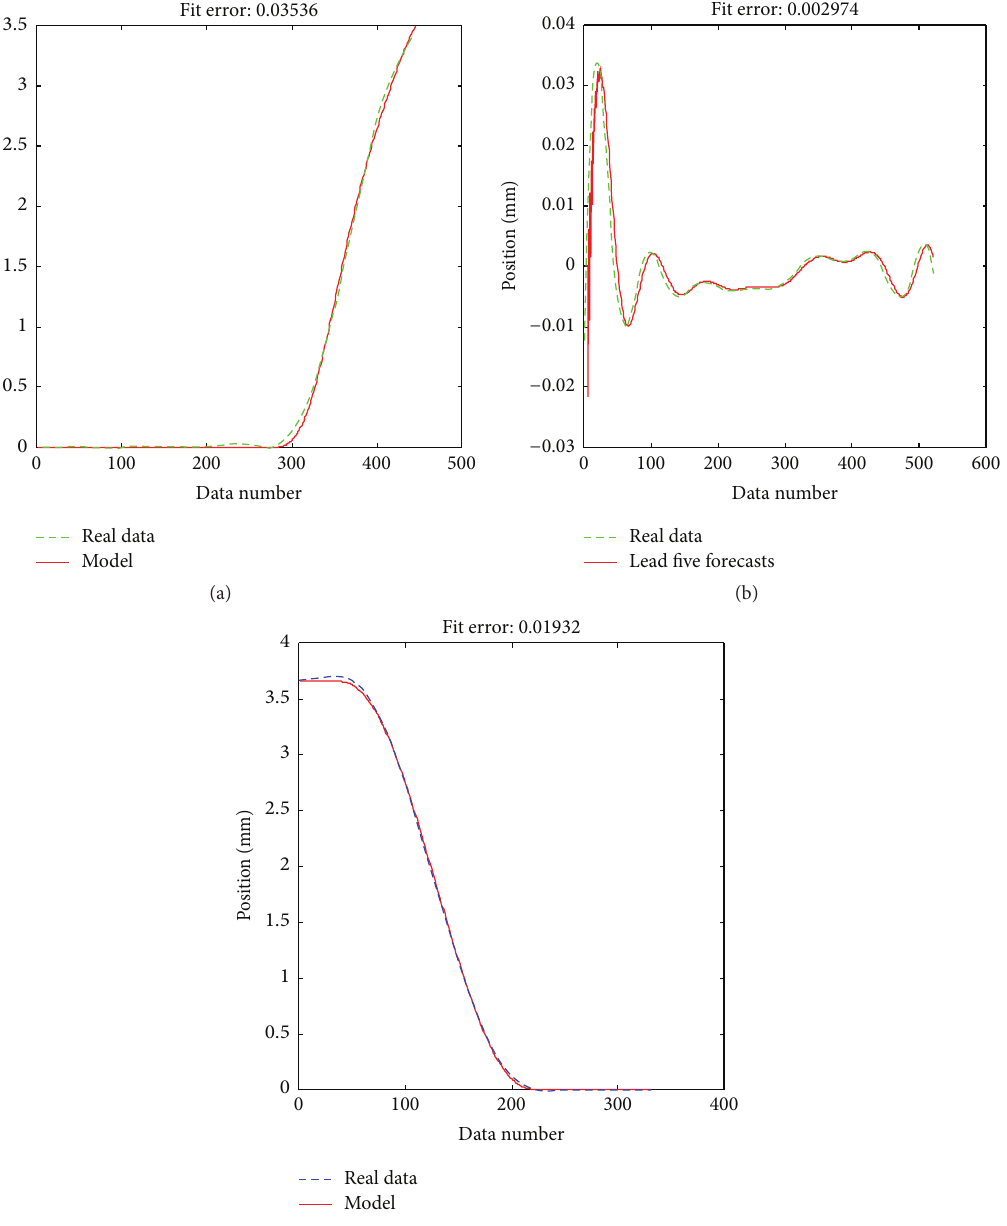
Figure 12: Model verification for the subsystem B for 120rpm operation speed: (a) section 1 , (b) section 2 , and (c) section 3